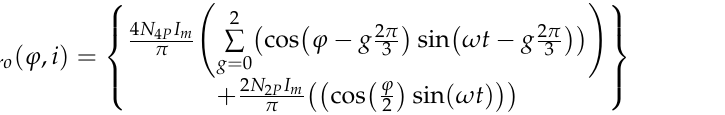
( b ) Figure 6. For proposed machine: ( a ) MMF Plot and ( b ) harmonic distribution. 3. FEM Analysis The 2D models of the reference and proposed machines were developed in ANSYS maxwell as shown in Figure 7a,b. To validate the operation and performance, both ma ‐ chines with the same dimensions and parameters were adopted, and are given in Table 1.